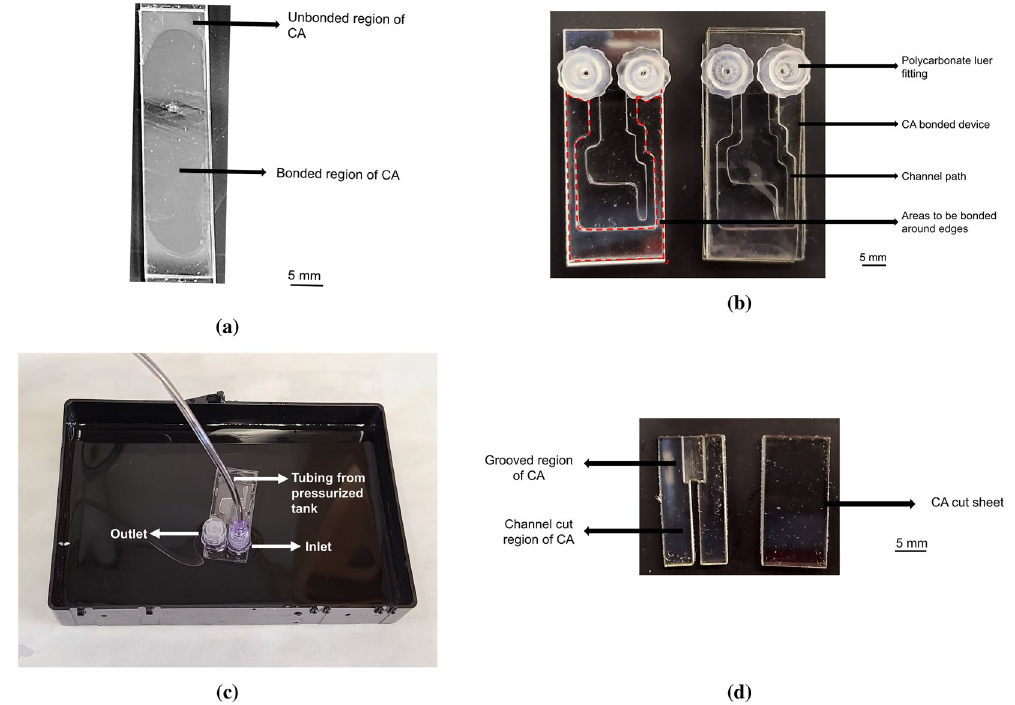
Figure 2. ( a ) Photograph of CA bonded device with unbonded and bonded regions. Bonded regions are darker than the unbonded regions. ( b ) Photograph of CA bonded device with relevant components for leakage and burst tests. ( c ) CA bonded device in operation during leakage or burst test with inlet operating from a pressurized tank using tygon tubing and outlet is locked with luer lock fitting. ( d ) Photograph of laser cut CA with channel cut and grooved regions for surface characteristic test of the sheets to be